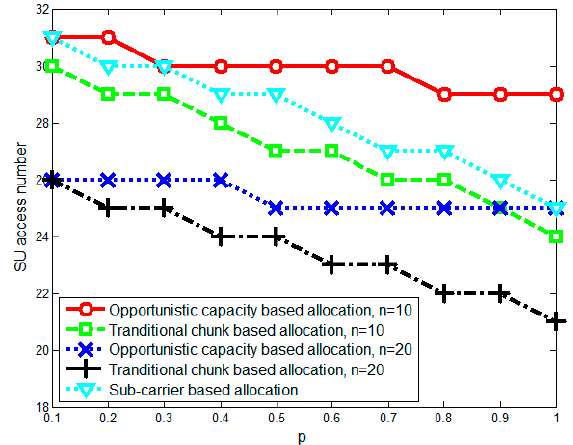
Figure 5. Number of secondary users (SUs) accessing the network with different chunk capacity change rates p .